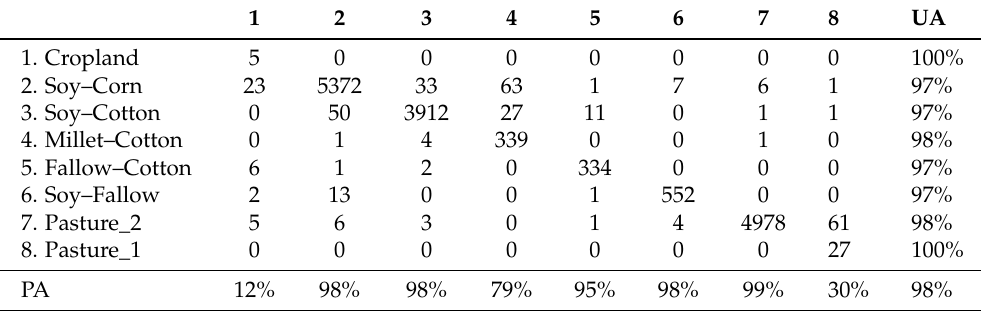
Table 2. Confusion matrix—the cropland samples mapped in pasture were kept in the